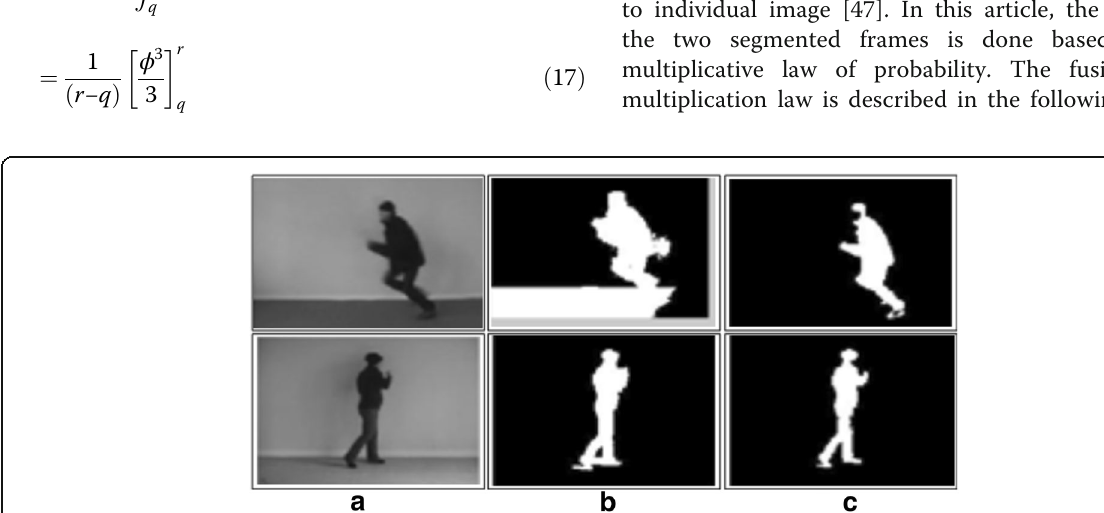
Fig. 4 Segmentation results. a Original frame. b EM segmentation. c Uniform